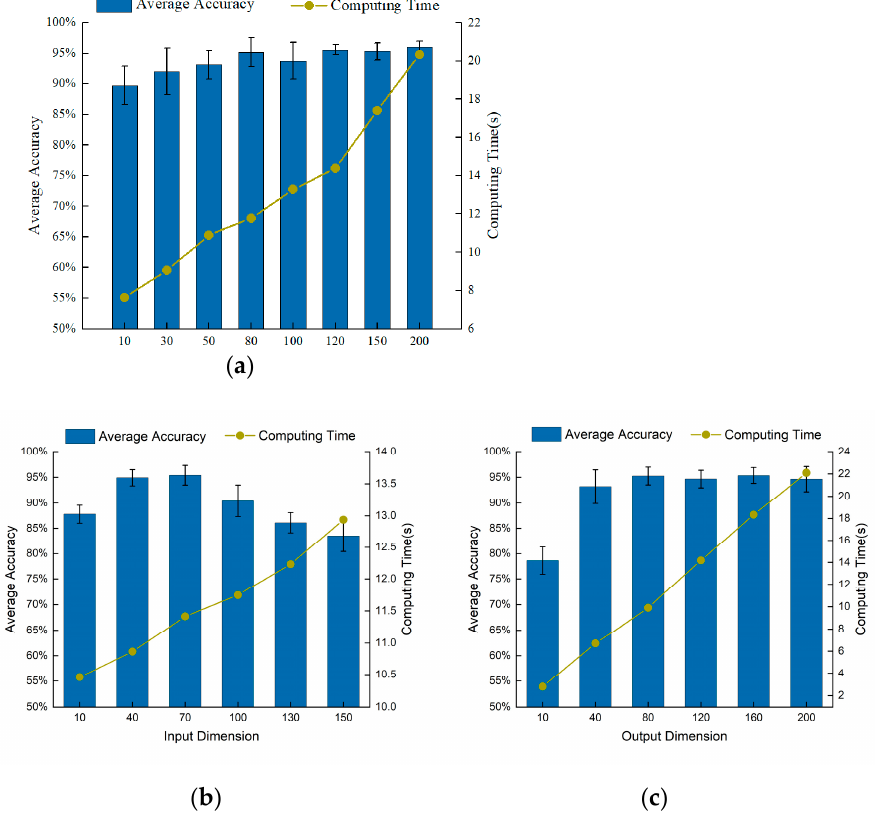
Figure 9. Influence of various parameters on diagnostic performance of GSLSF. ( a ) Number of segments. ( b ) Input dimension. ( c ) Output dimension.